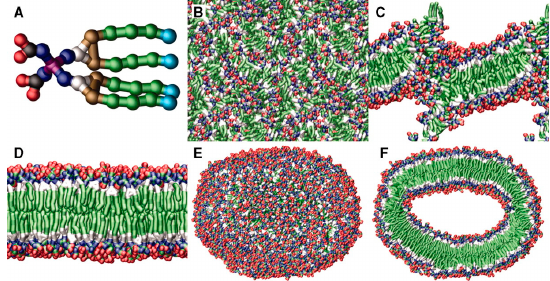
Figure 5. Self-assembly of the Janus dendrimer (3,5)12G1-PE-BMPA-(OH) 4 using CG-MD